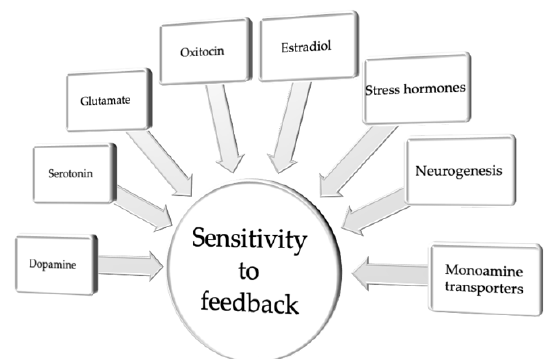
Figure 2. Neuromolecular and cellular correlates of sensitivity to feedback. Table 1. Pharmacological manipulations targeting various neurotransmitter systems, which affect pessimistic judgment bias or sensitivity to feedback.